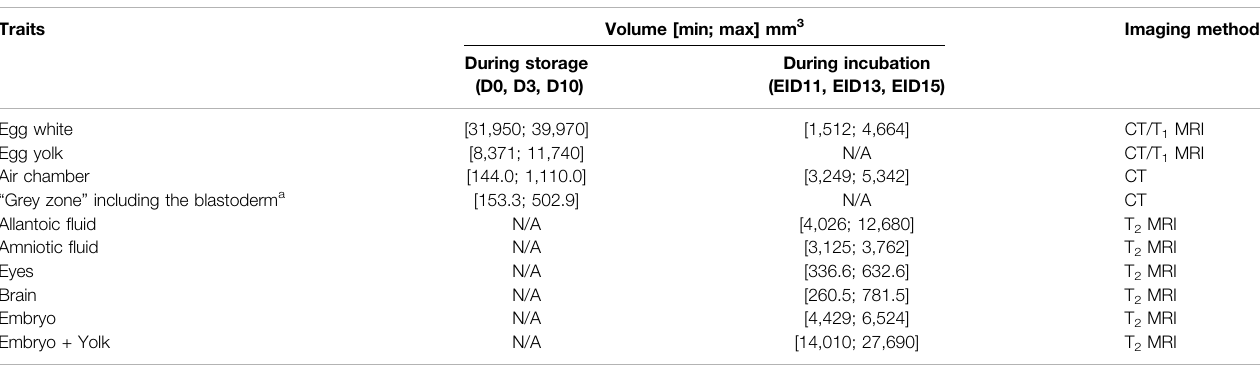
TABLE 1 | Egg analysis via imaging methods.